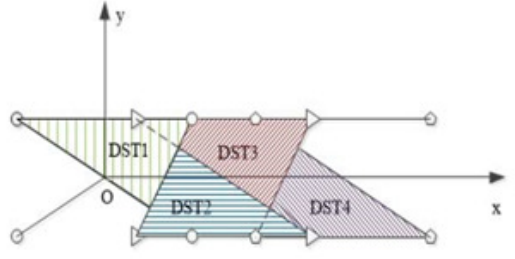
Fig. 7. Series of Double Support Triangles on the ground frame